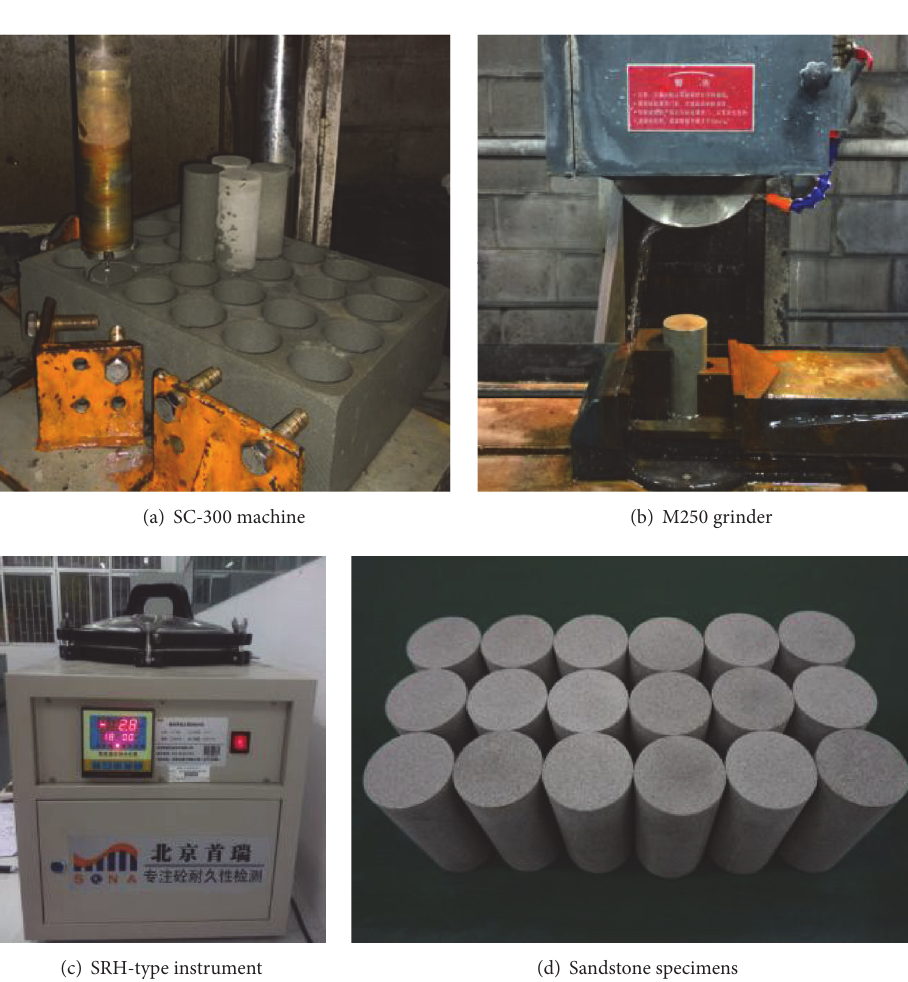
Figure 1: Part of the test apparatus and sandstone